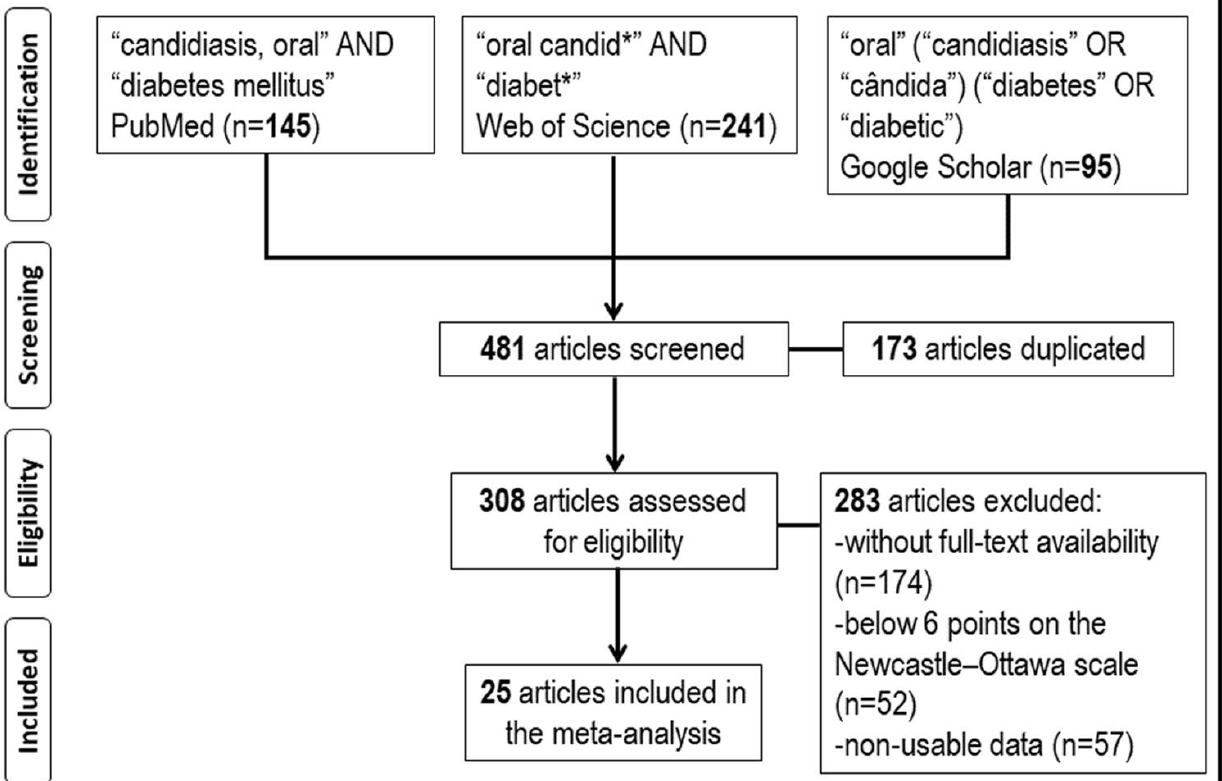
Figure 1 : Study flow